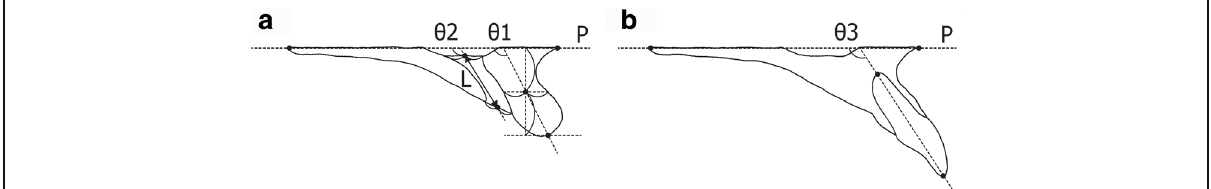
Fig. 2 Definitions of linear and angular measurements in the midsagittal plane. a PP palatal plane; L length of the incisive canal; θ 1 and θ 2 angles between the palatal plane and axes of the maxillary alveolar border and incisive canal, respectively. b θ 3 angle between the palatal plane and axis of the maxillary left central incisor